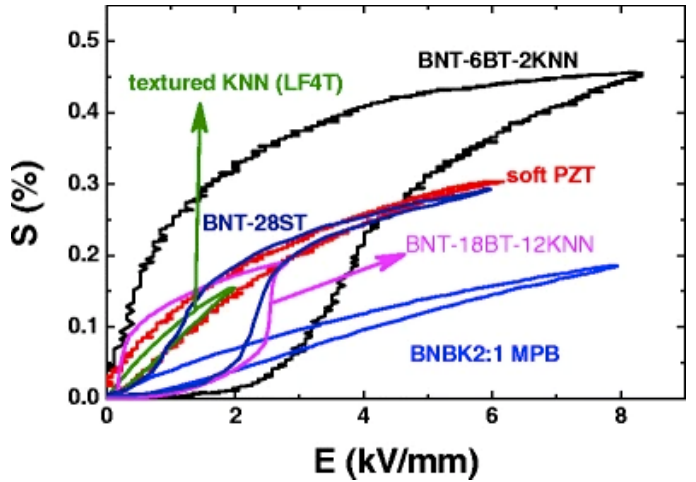
Figure 2. Electric-field-induced strain in comparison between soft PZT and BNT-based system. Reprinted with the permission of [28]. Copyright © 2012 Springer Nature. BaTiO 3 , (BT) is a representative lead-free piezoelectric material that has been studied for a long time for the grain size effect [31–34], crystal structure at the atomic and electron level [35–37], nanoparticles [38–40], and texturing [41,42], and it is still being actively per- formed even to this day. Recently, Liu and Ren et al. suggested in 2009 that Ca and Zr co- doped BT (BZT–BCT) has the potential to replace the PZT system [43]. BZT–BCT has a tricritical point as the coexistence of crystal structures with cubic, tetragonal, and